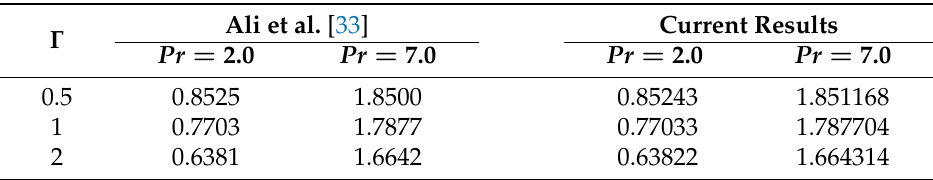
Table 2. The comparison of θ (cid:48) ( 0 ) against rotating Γ and Prandtl number ( Pr ) parameters when others involved parameters values are